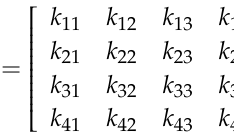
Table 2. Importance scale values of judgment matrix. Importance Scale Value Meaning 1 Both elements are of equal importance 3 One element is slightly more important than the other 5 One element is more important than the other 7 One element is extremely important than the other 9 One element is absolutely important than the other 2,4,6,8 Represents the middle value of the above